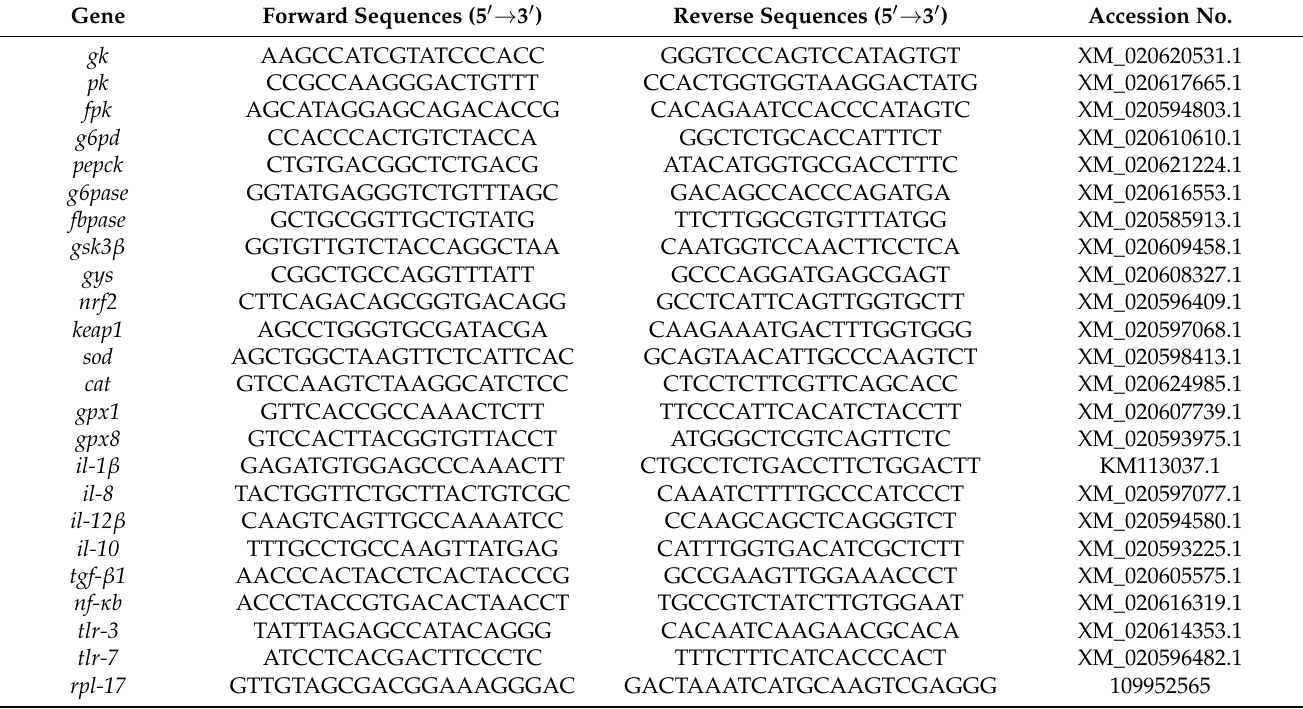
Table 2. Primers used for mRNA quantitative real-time